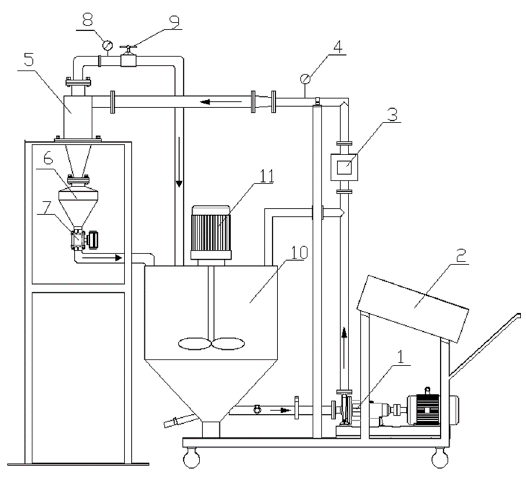
Figure 2. The diagram of the experimental system. 1—slurry pump; 2—central control box; 3—flow meter; 4—pressure gauge; 5—hydrocyclone; 6—concentrated hopper; 7—pneumatic valve; 8—relief pressure gauge; 9—backpressure valve; 10—mixing drum; 11—stirrer.